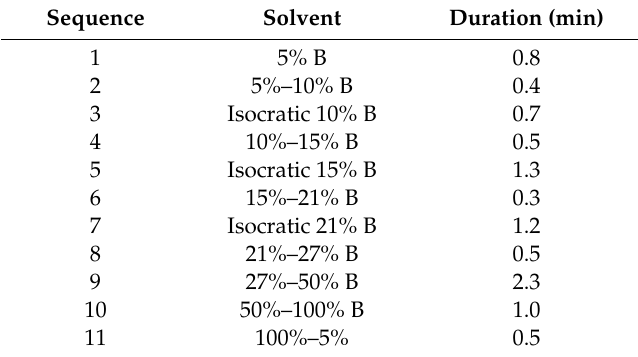
Table 5. The sequence of linear gradients and isocratic flows of solvents in the mobile phase of the reversed-phase UHPLC. Sequence